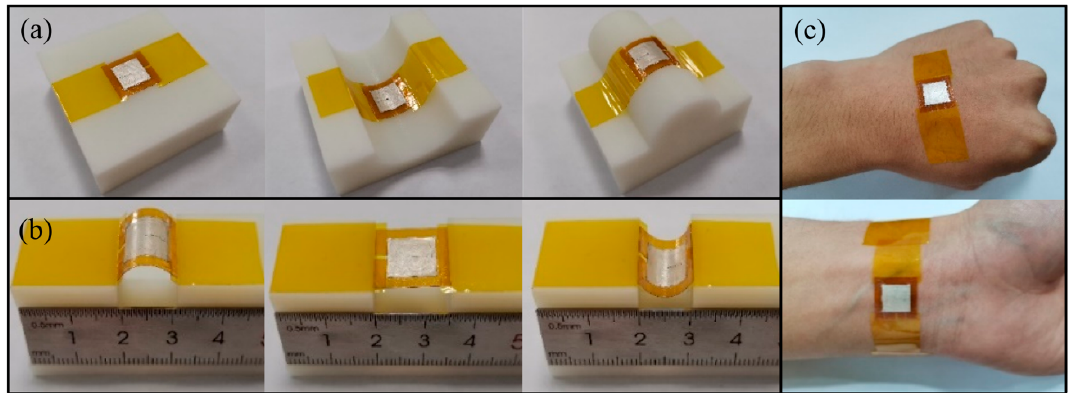
Figure 15. The optical images of PMUT ( a ) bonded on flat (left), concave (middle), and convex (right) surfaces, ( b ) clamped on a custom-designed linear mobile platform in up-bending (left), flat (middle) and down-bending (right) configurations, and ( c ) contacted to the skins.